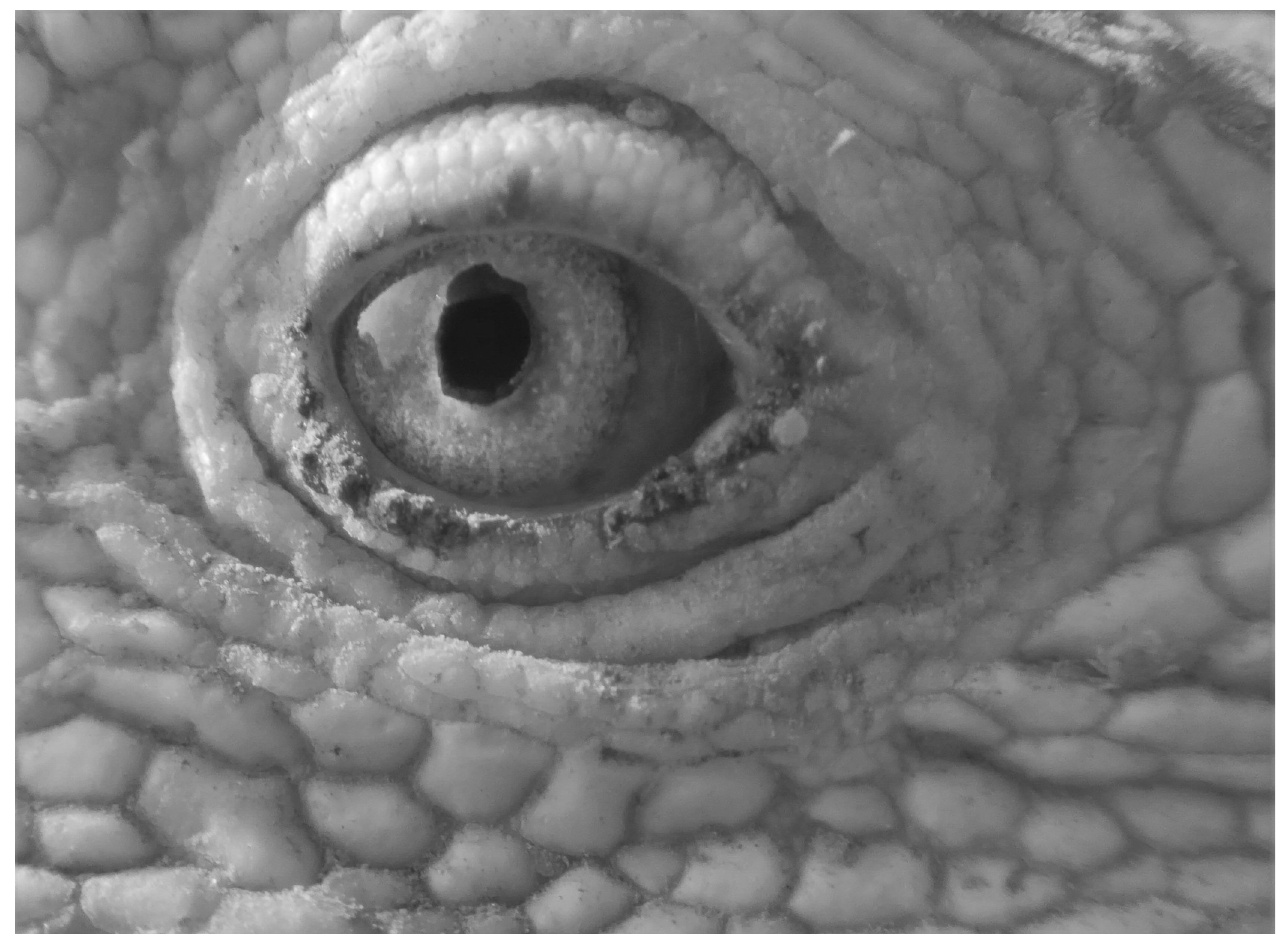
Fig 2. Detail of infrared eye photography. This image shows a detail of the infrared images collected and analyzed.